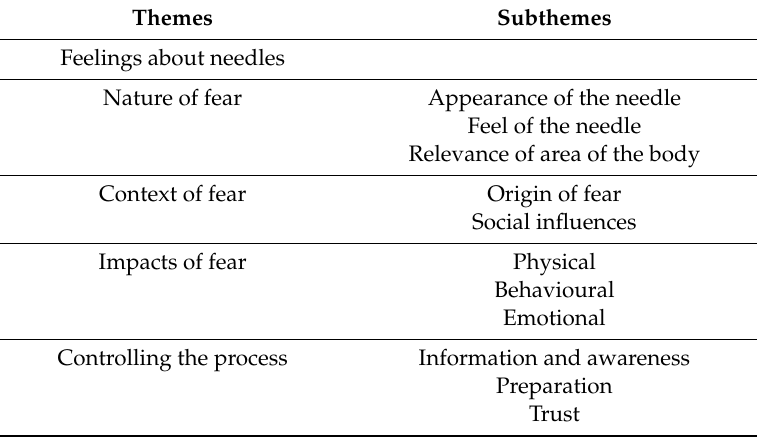
Table 2. Themes and